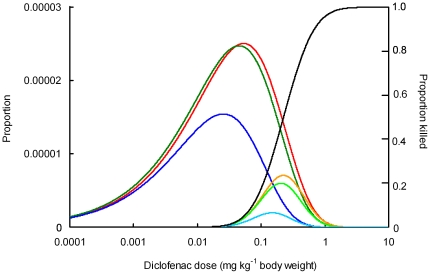
Comparison of probability density functions of diclofenac dose per unit vulture body weight from ungulate tissue before and after the ban on the veterinary use of diclofenac.Probability density functions are shown of estimated diclofenac dose (mg kg−1 wet weight) per meal for birds eating a mixture of all edible ungulate tissues and feeding at intervals of three days. Results are shown for three surveys: red = T1, pre-ban, dark green = T2, soon after the ban, dark blue = T3, 7–31 months after the ban. The proportion of vultures expected to be killed by a given dose of diclofenac is shown by the dose-response curve (black, with right-hand y axis). The products of the dose probability density functions and the dose-response curve are shown by the orange, light green and light blue curves for surveys T1, T2 and T3 respectively. The areas under these curves give the estimated proportion of vultures killed per meal.